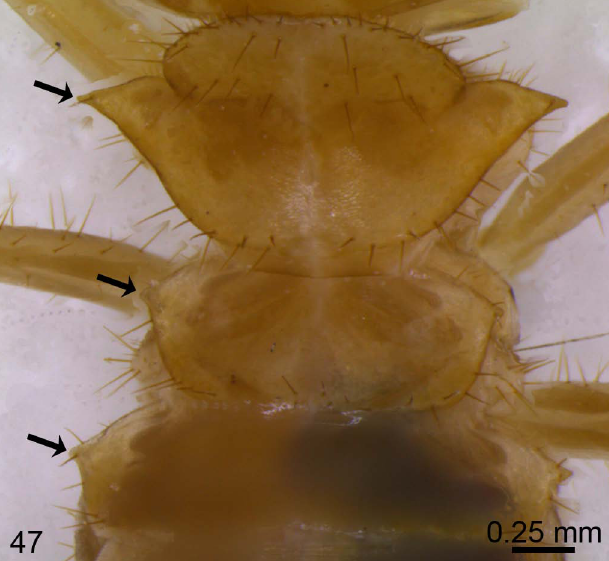
Fig 47. Thoracic nota of Syntermes spinosus worker (arrows: lateral projections).